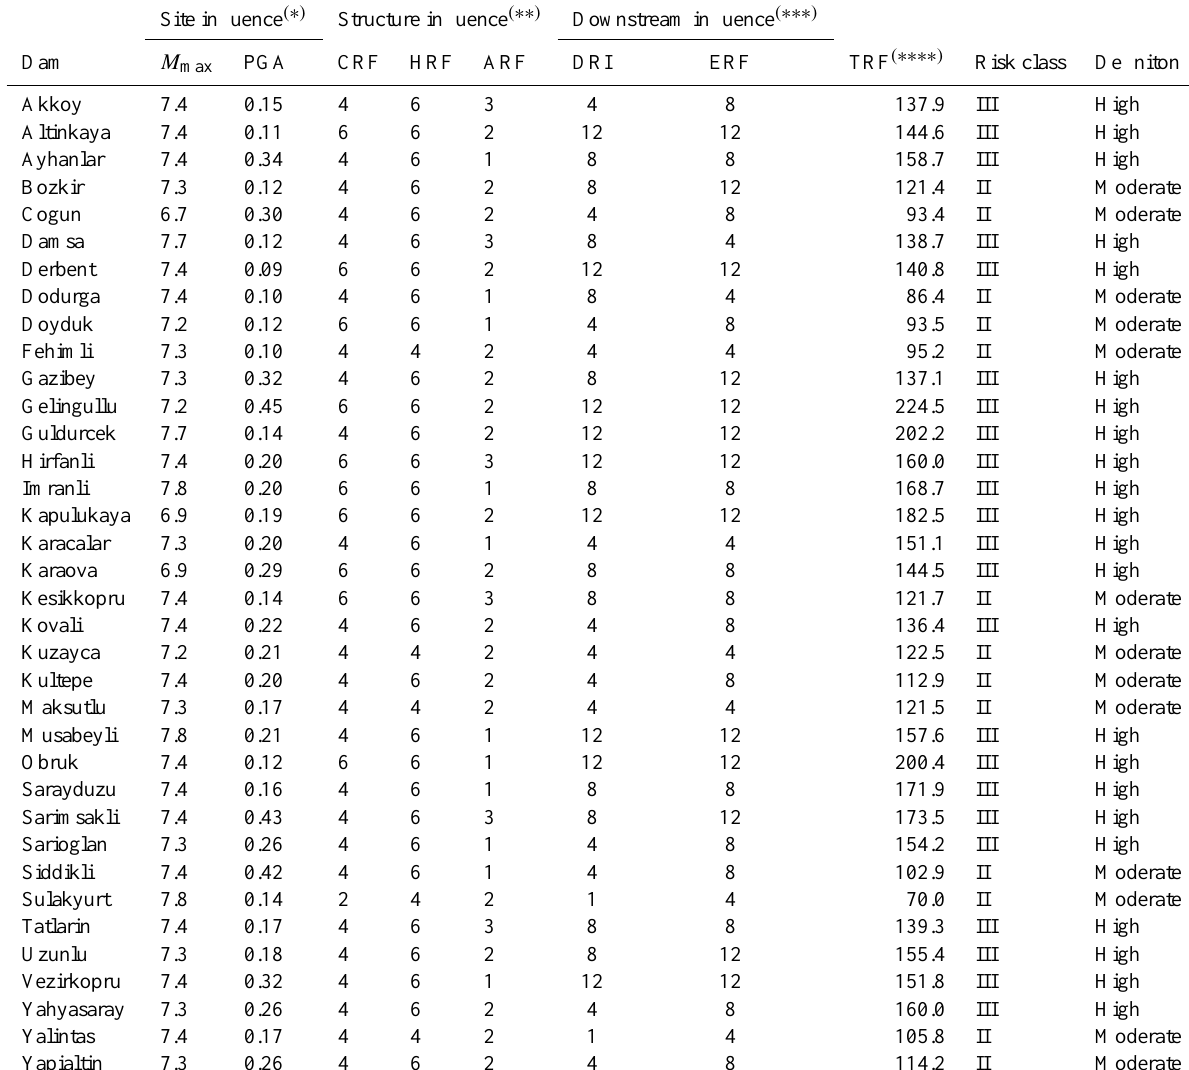
Table 4. Summary of total risk analyses performed for the large dams within the Kizilirmak